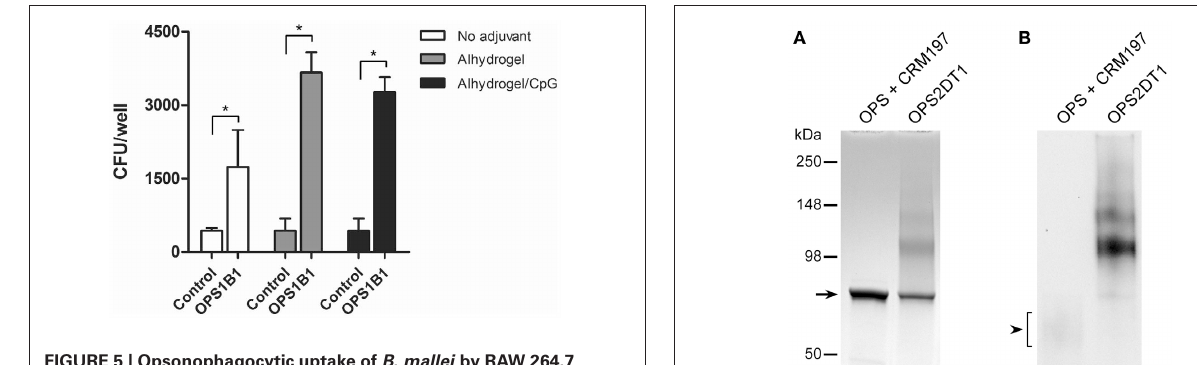
FIGURE 5 | Opsonophagocytic uptake of B. mallei by RAW 264.7 murine macrophages. Bacterial uptake in the presence of HI pooled vehicle/adjuvant only control serum (Control; n = 6) or pooled anti-OPS1B1 immune serum (OPS1B1; n = 6) was quantitated at 3h post-infection. Values represent the means ± SD of three independent experiments. ∗ P < 0 . 05.